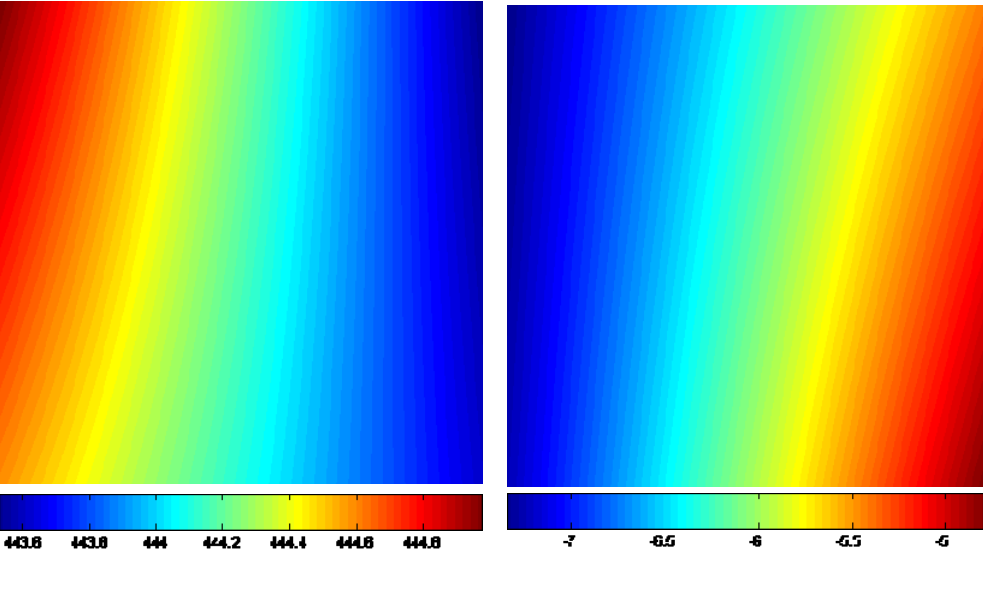
Figure 5. The non-coseismic components of AZO (left) and RO (right) estimated from the GPS observations. Units: